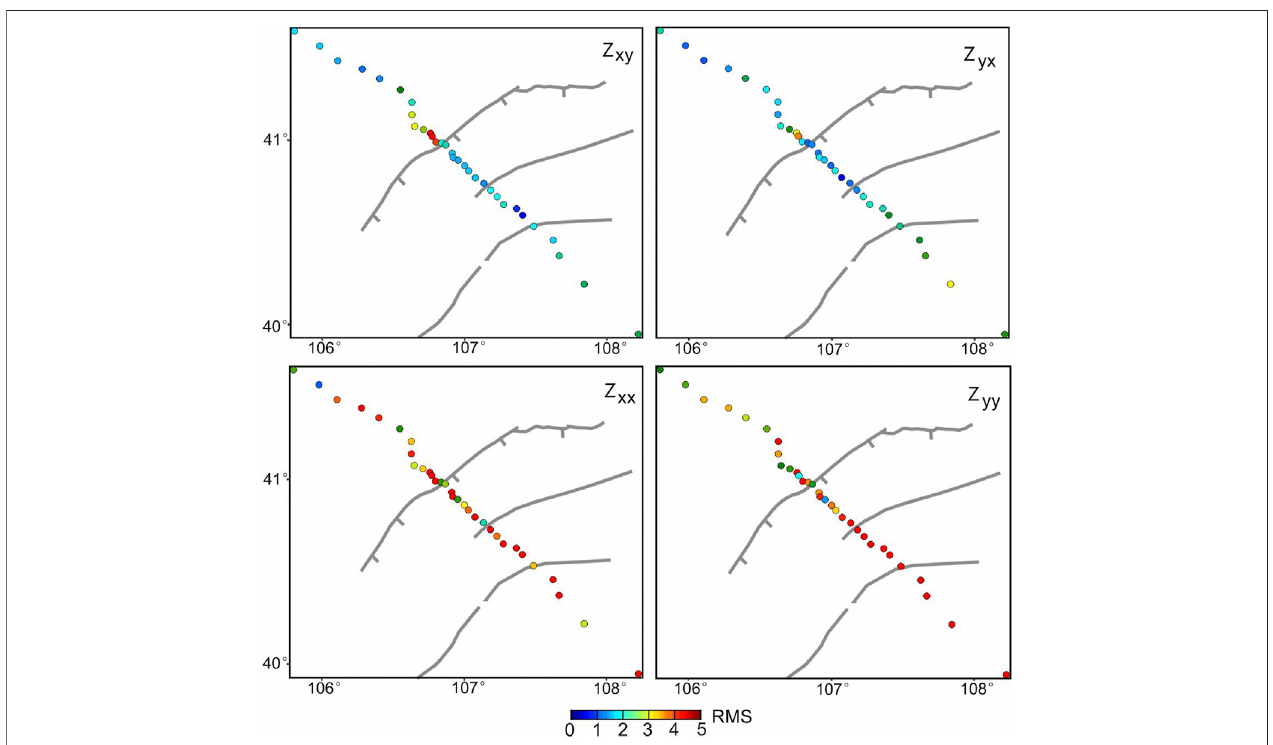
FIGURE4| Rootmeansquareerror(RMS)distributionoffourcomponents(Zxy,Zyx,Zxx,Zyy)ateachmagnetotelluric(MT)siteofthethree-dimensionalinversion.